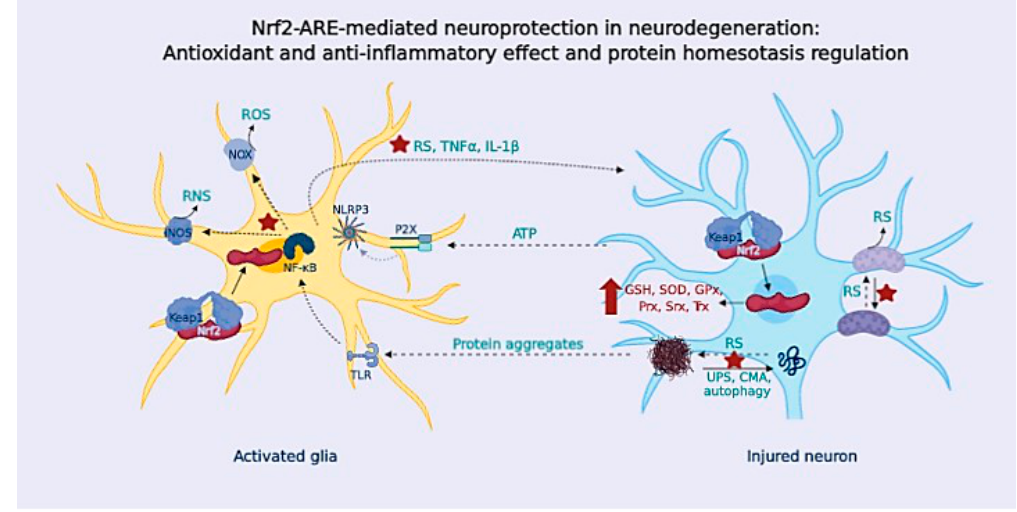
Figure 5. The Nrf2-ARE pathway provides neuroprotection in multiple ways. The activation of the Nrf2-ARE pathway increases the expression of antioxidant enzymes and GSH levels, thus preventing the damage to biomolecules, mitochondrial dysfunction, and neuronal apoptosis. Nrf2-ARE pathway upregulation prevents OS-driven protein misfolding and aggregation, and also stimulates the UPS and autophagy systems to control the cellular proteostasis. Additionally, the Nrf2-ARE pathway exerts anti-neuroinflammatory properties, induces the expression of the anti-inflammatory enzyme HO-1, interferes with the transcription of the inflammatory NF- κ B pathway, and down-regulates NOX and iNOS-derived RS. The antioxidant and anti-neuroinflammatory e ff ect and protein homeostasis regulation mediated by the Nrf2-ARE pathway prevents